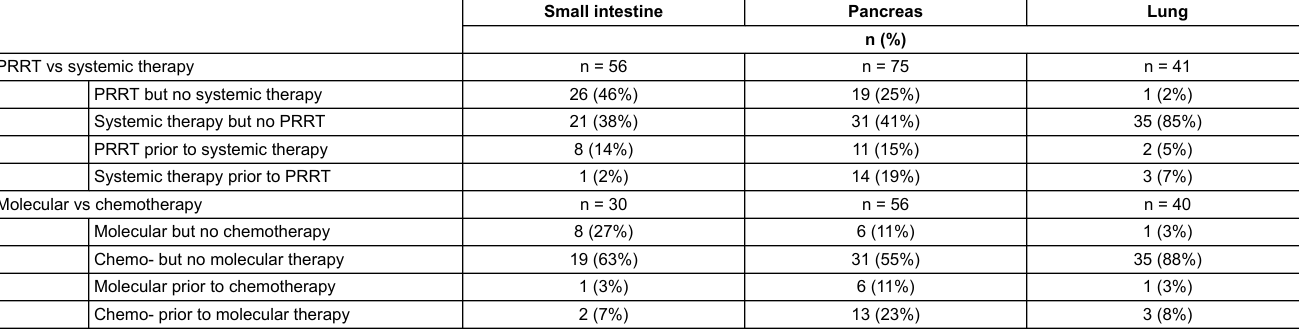
Small intestine Pancreas Lung n